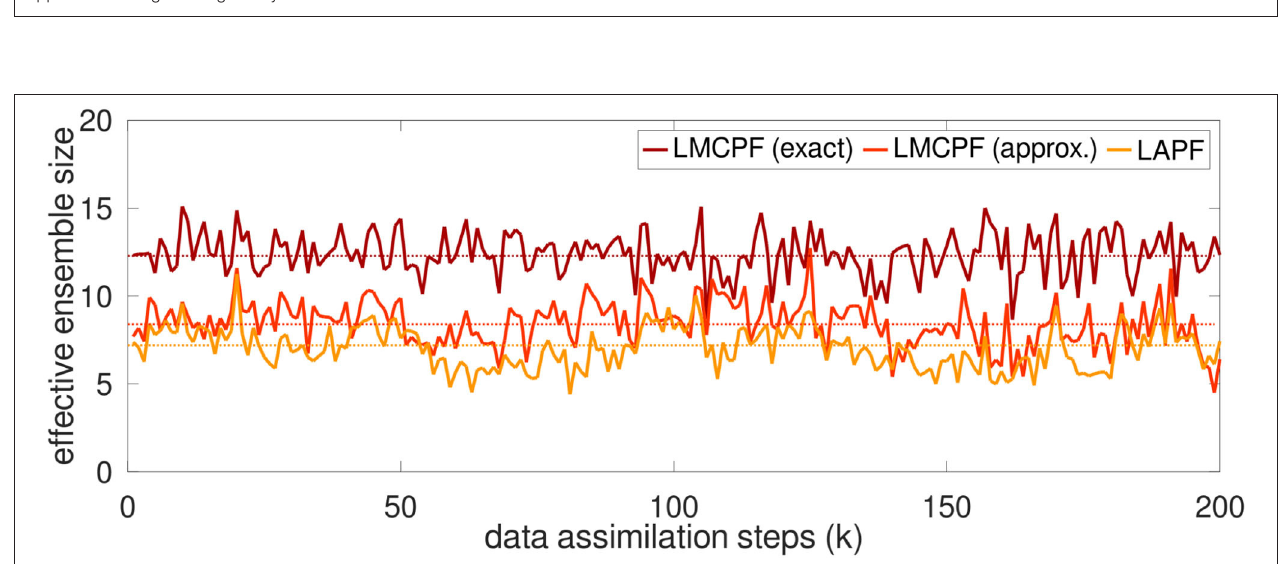
20. Every second variable of the = 8 and F 9.5 and the forecast length is set to 1 t 0.3. The observation = = = I m . The particle uncertainty parameter is set to σ 2 obs 0.5 and the observation error covariance matrix as diagonal matrix R = = · 1.0 for the LMCPF with approximate weights. The background error mean of the last 900 data assimilation = 1.54 and the analysis error mean is approximately e ( a ) 0.95. The respective error means for the LMCPF with ≈ ≈ 1.62 and e ( a ) 1.06. ≈ ≈